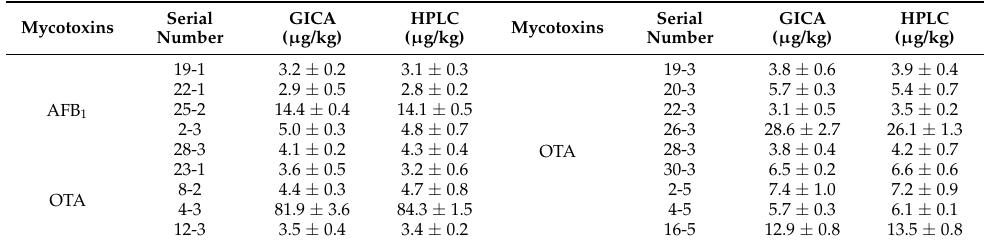
Table 8. Comparison of GICA and HPLC detection